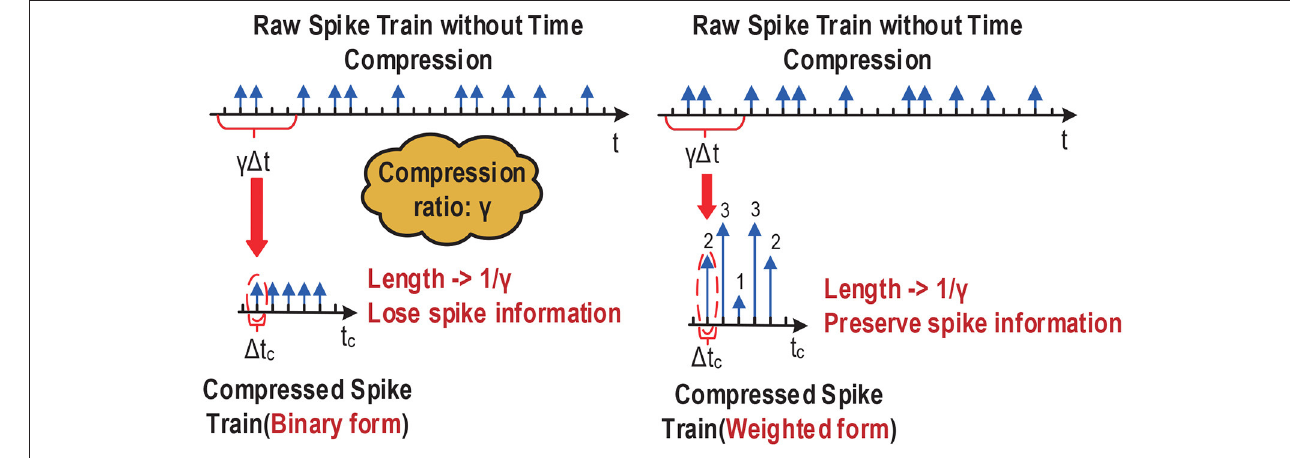
FIGURE 2 | Binary vs. (compressed) weighted spike trains.